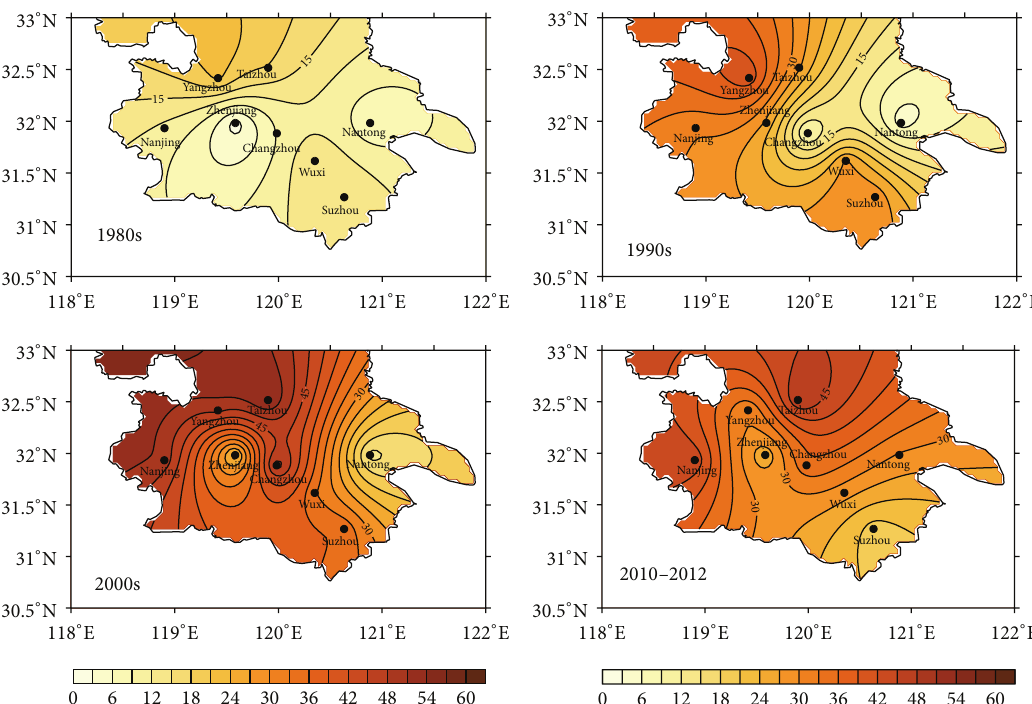
Figure 6: Space-time distribution of continuous hazy day south of the Huaihe River (yearly